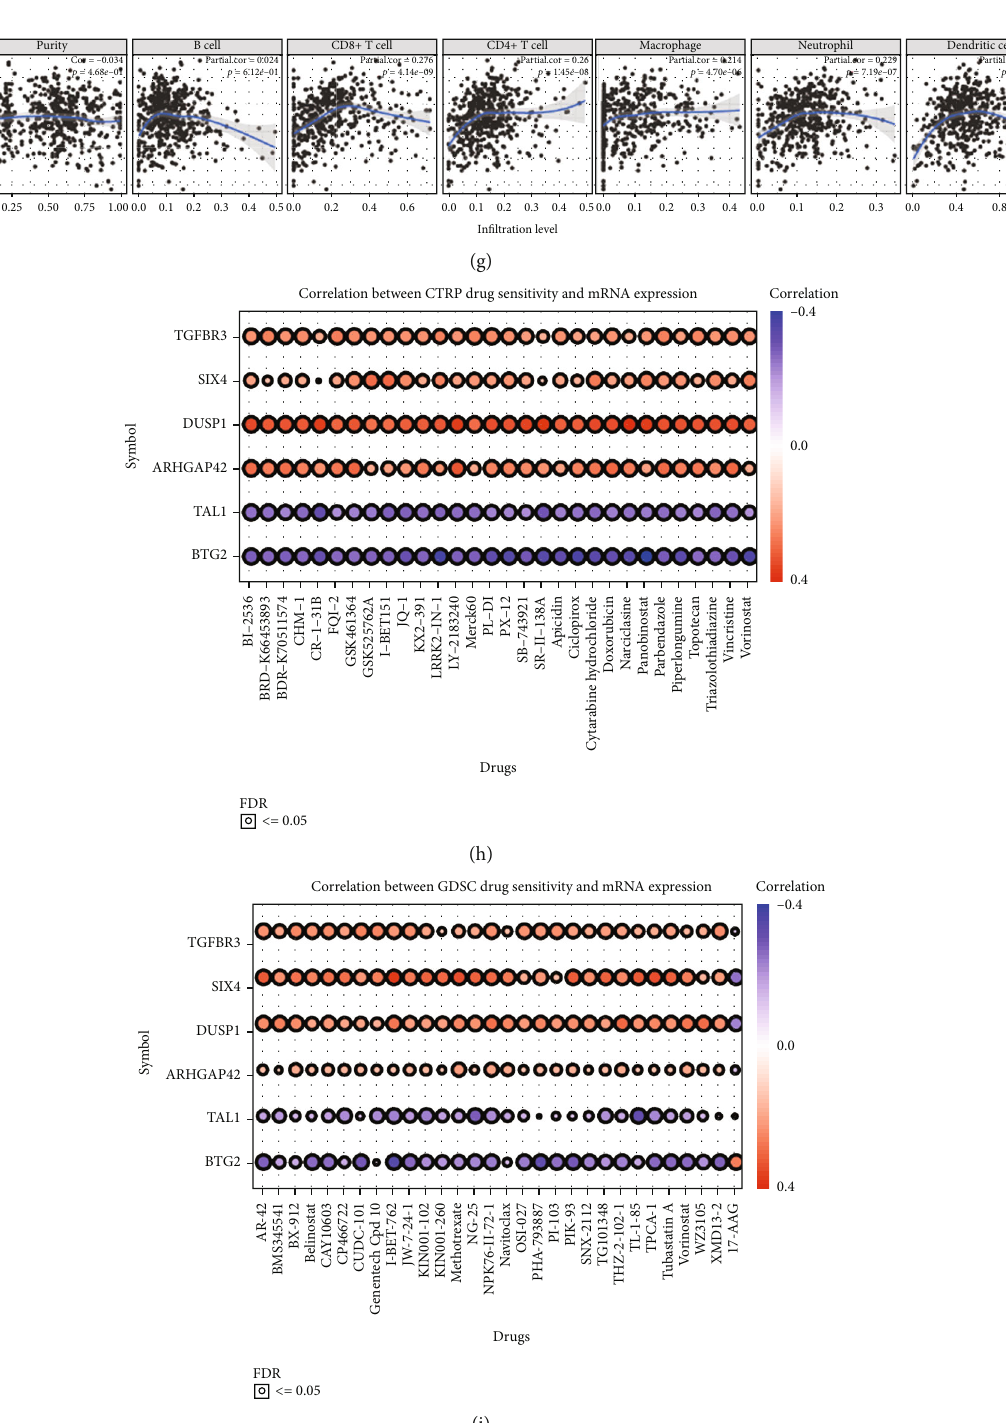
Figure 9: Tumor in fi ltration and drug sensitivity analysis of OS-related hub genes. (a – g) The tumor immune in fi ltration status of seven OS- related hub genes analyzed by TIMER. (h) Correlation between the expression of OS-related hub genes and CTRP drug sensitivity. (i) Correlation between the expression of OS-related hub genes and GDSC drug